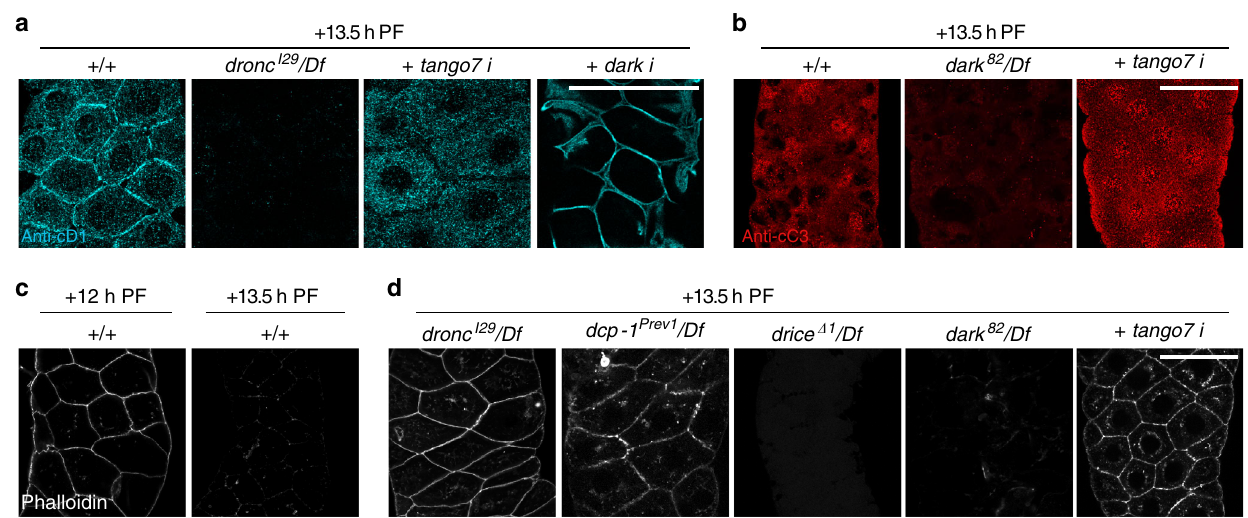
Fig. 4 Subcellular domains of caspase activation are independently regulated in dying salivary glands. a tango7 and dark regulate mutually exclusive subcellular domains of caspase activation in dying glands. Anti-cD1 staining, in cyan , is visible at both the cortex and in the cytoplasm of control salivary glands at + 13.5 h PF; both cortical and cytoplasmic staining is lost in dronc mutant salivary glands. Salivary gland-speci fi c knockdown of tango7 (with Sgs3-GAL4 ) does not affect cytoplasmic anti-cD1, but disrupts cortical anti-cD1. In contrast, salivary gland-speci fi c knockdown of dark (with fkh-GAL4 ) disrupts cytoplasmic anti-cD1 but not cortical anti-cD1. b Cleaved caspase-3 (anti-cC3, in red ), a diagnostic marker of caspase activation and apoptosis, does not require tango7 . Anti-cC3 staining is visible only in the cytoplasm of control glands at + 13.5 h PF; this staining is lost in dark mutant animals. However, anti-cC3 staining is unaffected upon salivary gland-speci fi c RNAi knockdown of tango7 (using Sgs3-GAL4 ). c Cortical F-actin is dismantled in dying salivary glands. The cortical F-actin cytoskeleton is intact in control salivary glands at + 12 h PF, just prior to the death response (phalloidin, in white ). However, phalloidin staining shows that F-actin is dismantled at + 13.5 h PF. d F-actin dismantling during the death response requires dronc , dcp-1 , and tango7 . Phalloidin staining, in white , indicates that F-actin breakdown is disrupted in dronc and dcp-1 mutant and tango7-RNAi ( Sgs3-GAL4 ) salivary glands at + 13.5 h PF, but F-actin breakdown is unaffected in drice and dark mutant salivary glands. Scale bars represent 100 µ m. Df, de fi ciency,